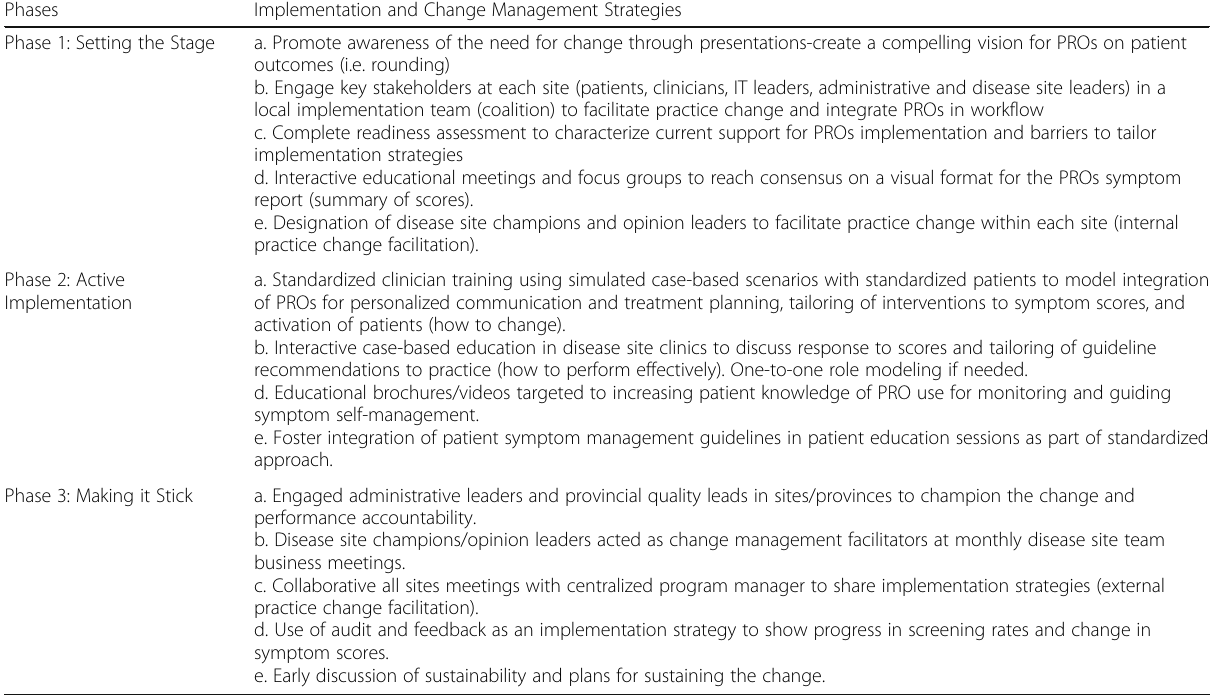
Table 1 Implementation Phases and Implementation